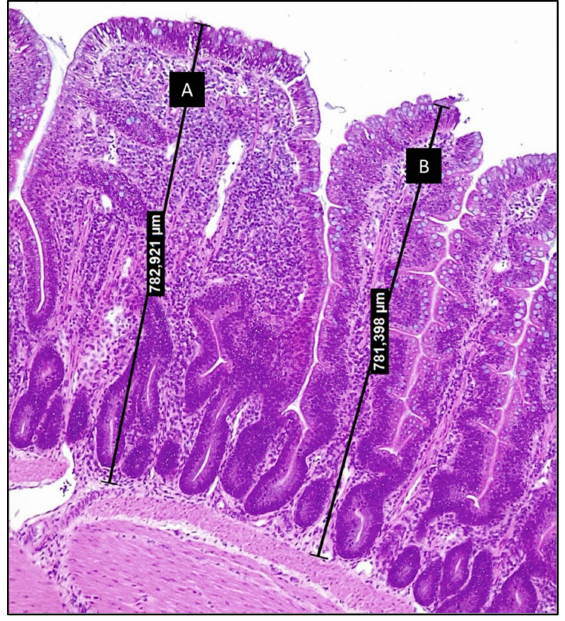
Figure 1. Photomicrography of chicken ileum section stained with hematoxylin and eosin (200 × ) (from authors archive). Villi A and B display very close heights, although villus A presents increased lamina propria thickness and increased infiltration by inflammatory cells. These alterations are comprised by the ISI methodology and allow to relate structural alterations to the loss of